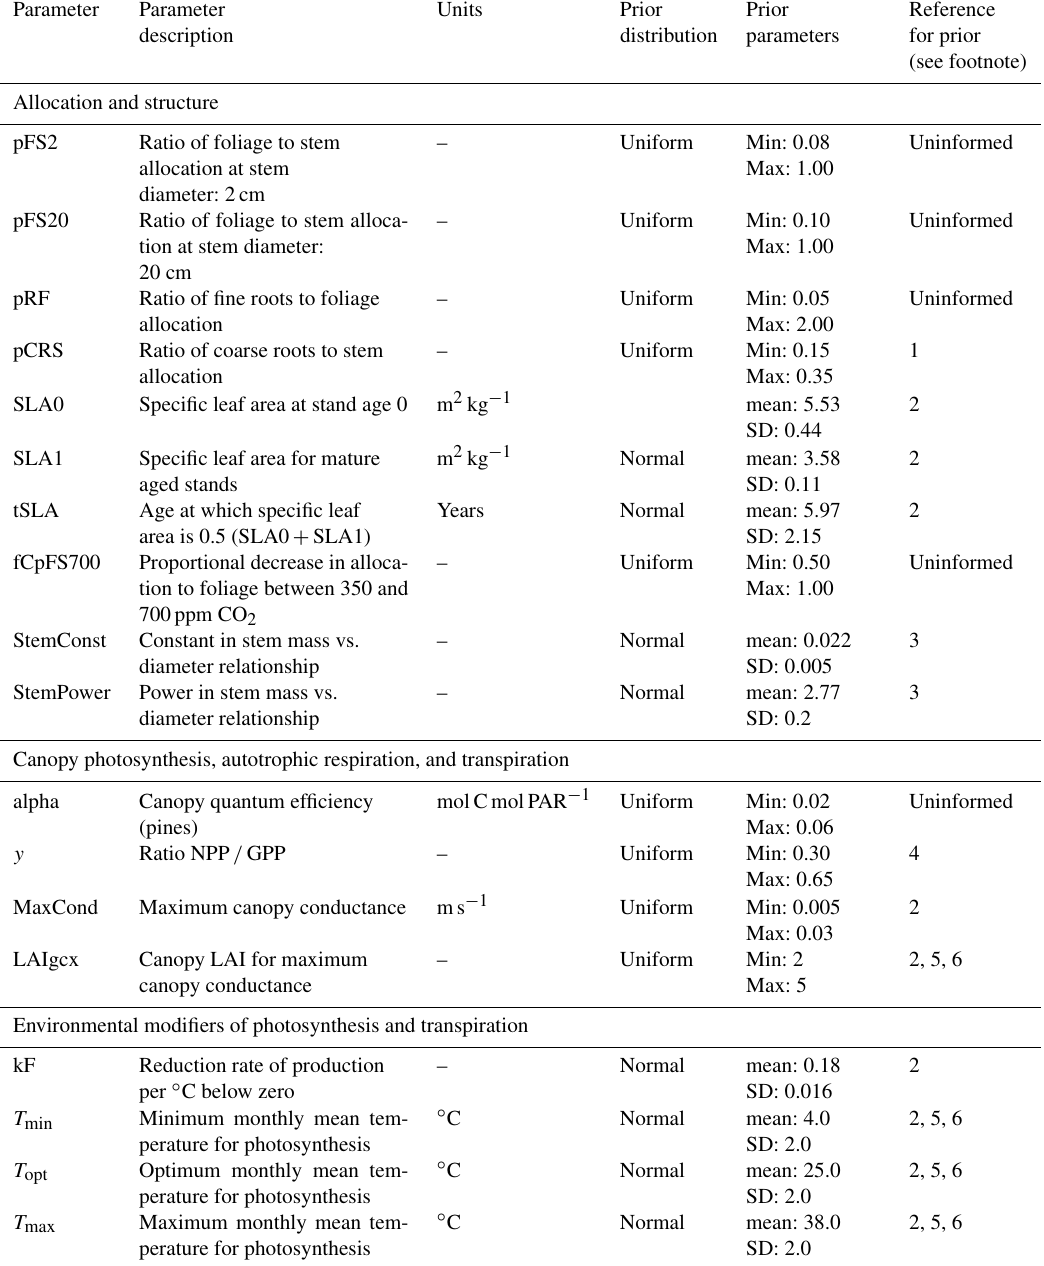
Table 3. The prior distributions of all 3-PG model parameters optimized using data assimilation. NPP: net primary production. Parameter Parameter Units Prior Prior Reference description distribution parameters for prior